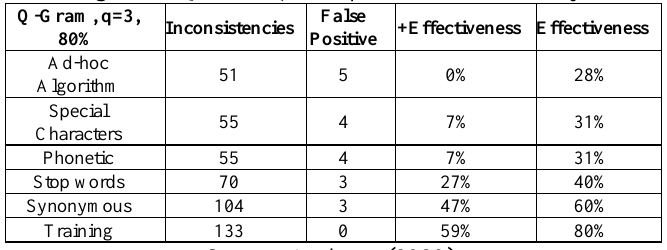
Table 9: Results obtained with data cleaning process using the algorithm Q-Grams, with q=3 and 80% similarity.